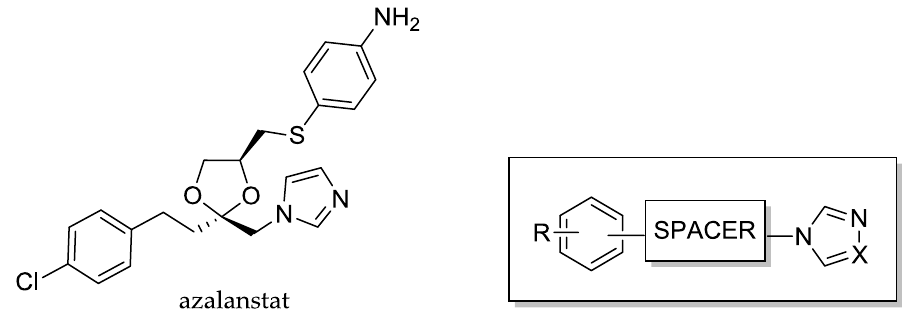
Figure 1. Azalanstat and simplified structure of HO-1 inhibitors.